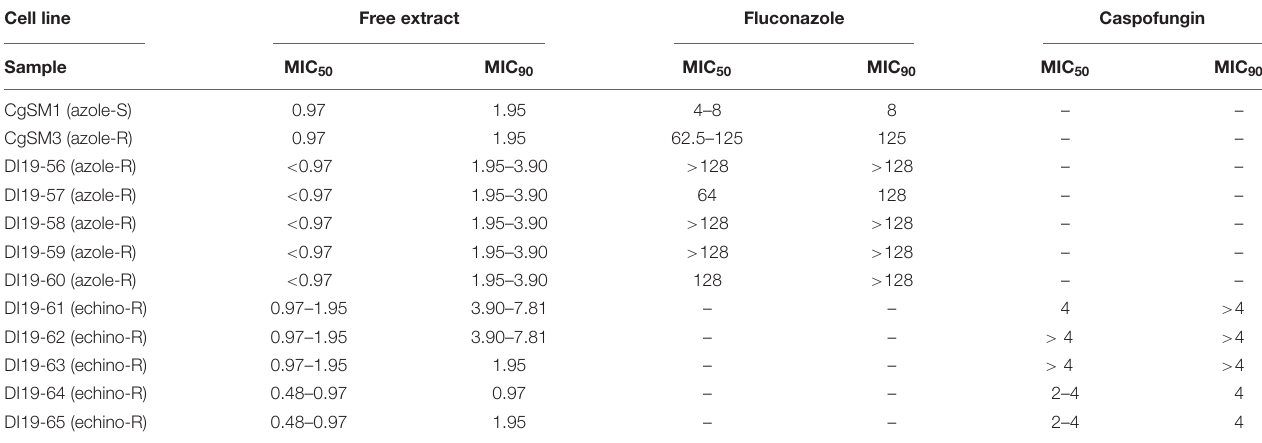
TABLE 3 | The inhibitory effect of the free extract and standard antifungals fluconazole and echinocandin against resistant C. glabrata clinical isolates. Cell